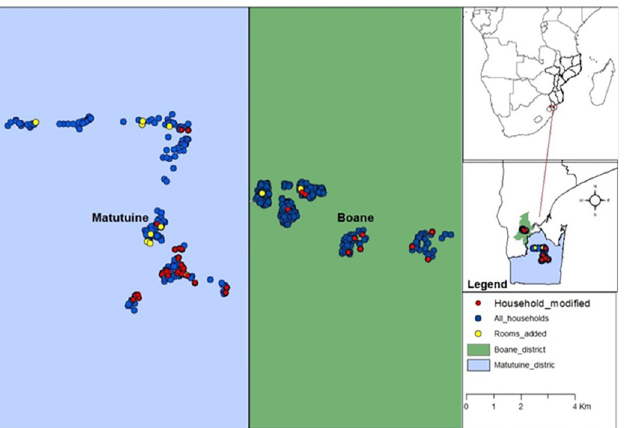
Fig 1. Map of Matutuine and Boane districts in southern Mozambique showing households with walls modified (red dots) and rooms added (yellow dots) to the households. The base layer was obtained from: https://data. humdata.org/dataset/mozambique-administrative-levels-0-3.